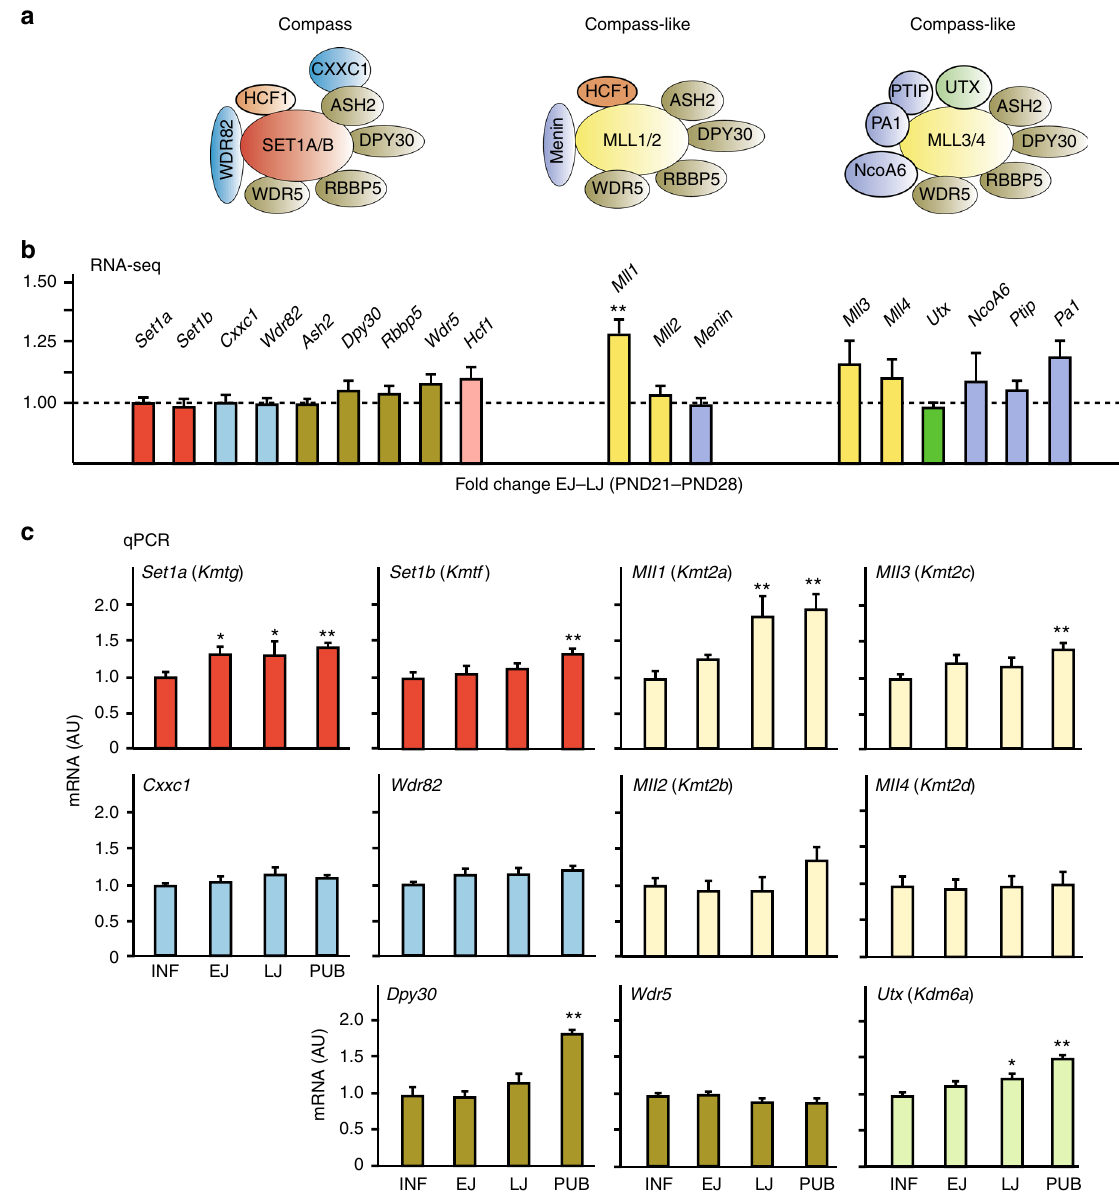
Fig. 1 TrxG gene expression in the prepubertal female rat hypothalamus. a The COMPASS families (for details see Introduction). b Expression of COMPASS genes in the MBH of prepubertal female rats assessed by RNA-seq. Data are represented as fold change between the early juvenile and the late juvenile groups (EJ/LJ). Dotted line depicts the EJ/LJ ratio of 1. Bars represent mean ± s.e.m. ( n = 4). ** P < 0.01 vs. EJ group; Student ’ s t -test. c Expression of COMPASS genes in the MBH of peripubertal female rats as determined by qPCR. RNA expression data were normalized using peptidylprolyl isomerase A as the housekeeping gene and by dividing each individual value by the average of the INF group. Bars represent mean ± s.e.m. INF = infantile ( n = 7 – 8); EJ = early juvenile ( n = 5 – 7); LJ = late juvenile ( n = 6 – 8); PUB = pubertal ( n = 6 – 9), day of the fi rst preovulatory surge of gonadotropins. * P < 0.05; and ** P